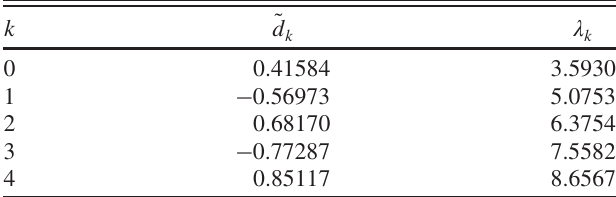
TABLE I. Table of the first five eigenvalues and coefficients for D ¼ 2 = 5